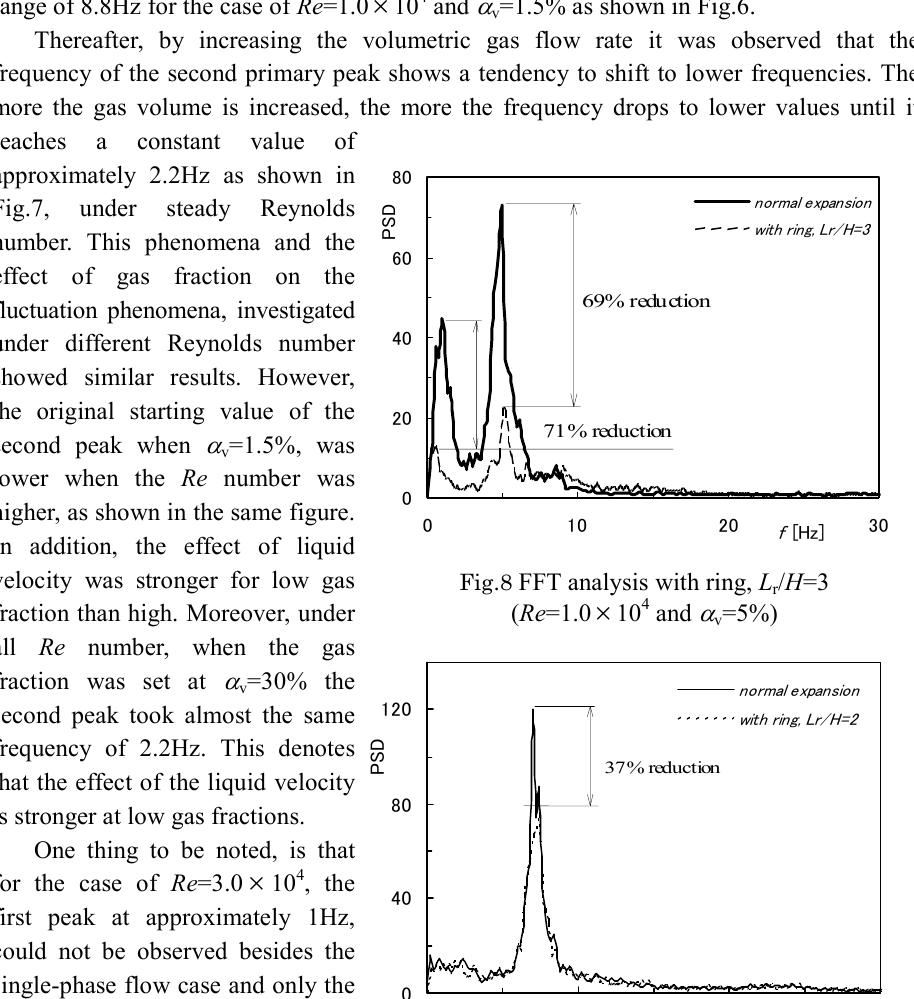
Fig.9 FFT analysis with ring, L ( Re =3.0 × 10 4 and α